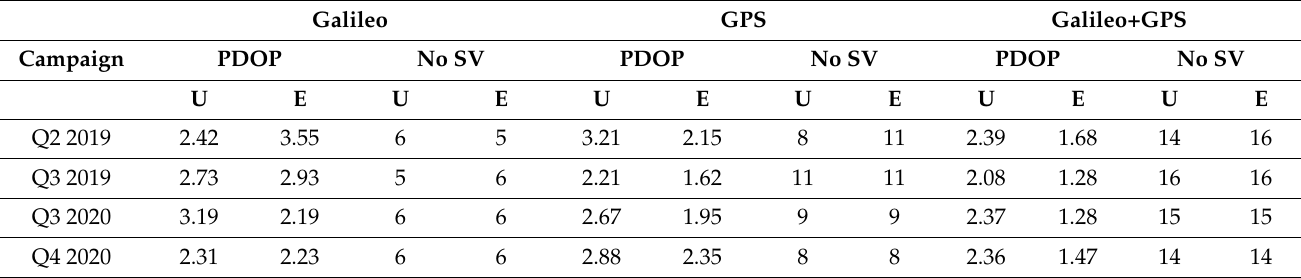
Table 9. Average PDOP and maximum satellites number during the terrestrial data-collection campaigns.